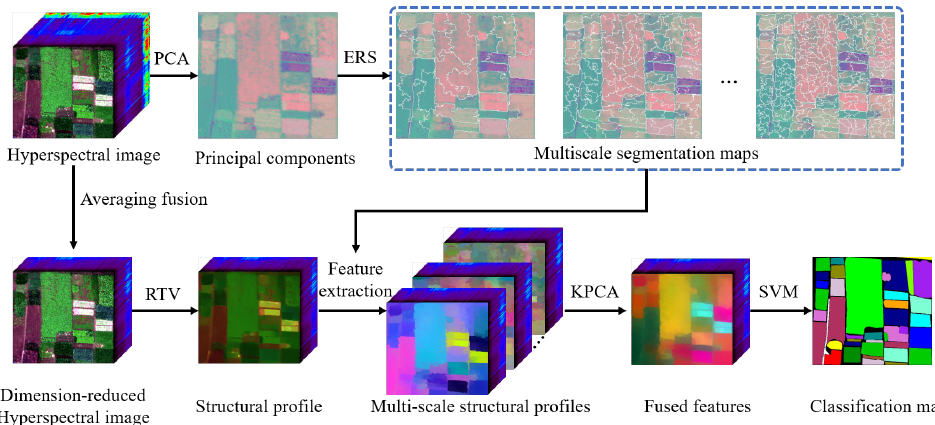
Figure 1. Schematic of the proposed classification